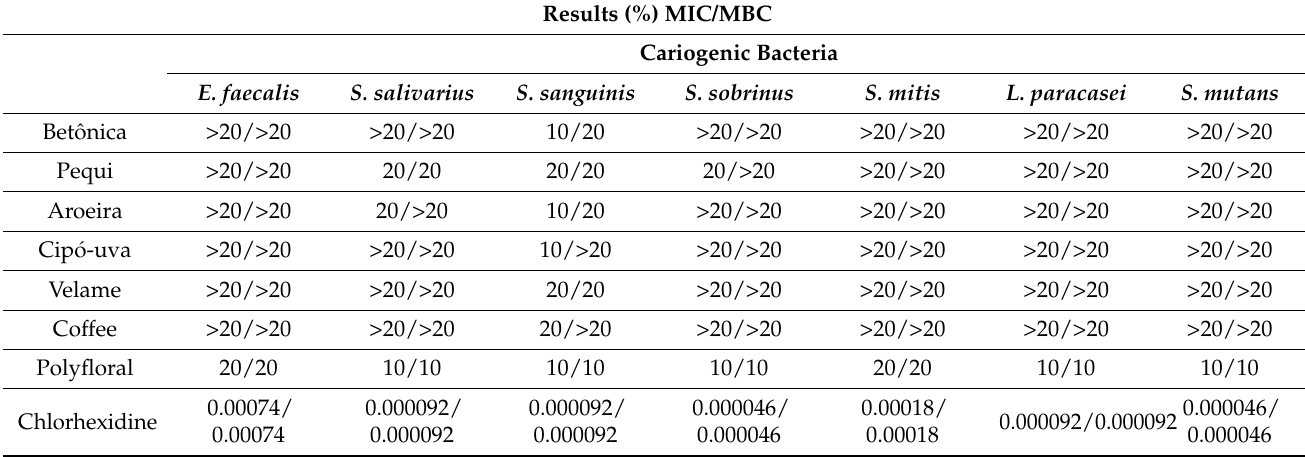
Table 8. Results of minimum inhibitory concentration/minimum bactericidal concentra- tion